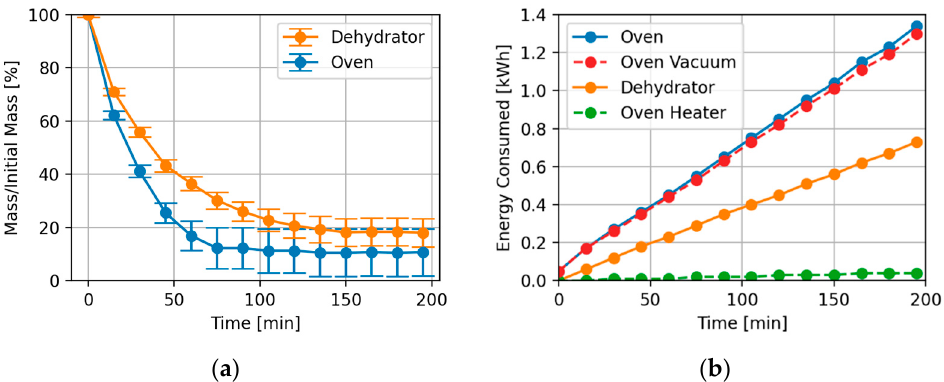
Figure 23. Dehydration measurements on consortium of microorganisms. ( a ) Percent initial mass for each sample; ( b ) energy consumption. The dashed oven vacuum and oven heater curves were summed to form the aggregate oven curve.